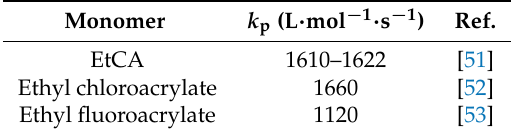
Table 3. Propagation rate coefficient ( k p ) values at 30 ◦ C using the rotating sector method.